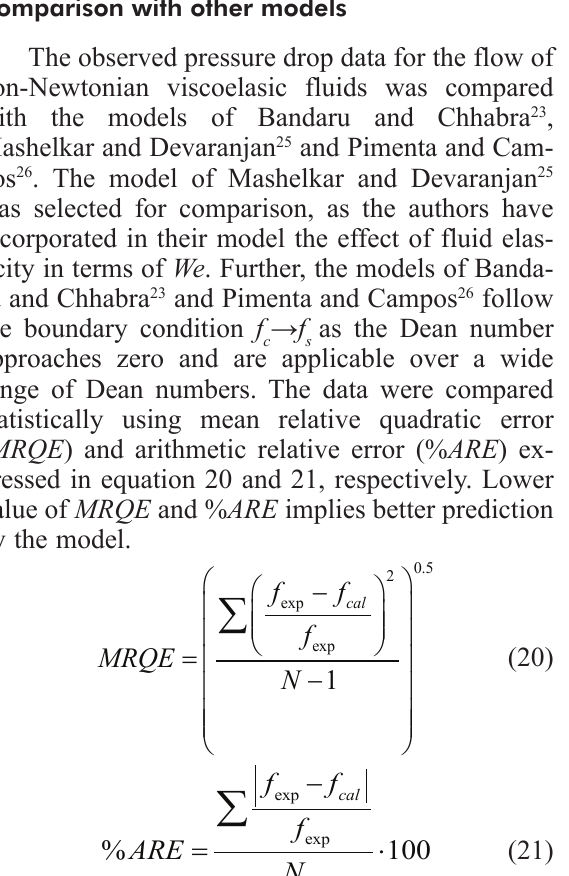
Fig. 5 – Functional relationship between ((f